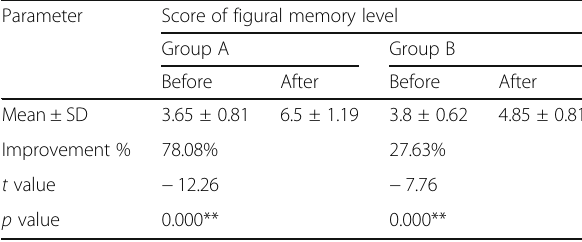
Table 2 Comparison of mean scores of figural memory level pre and post treatment within each group